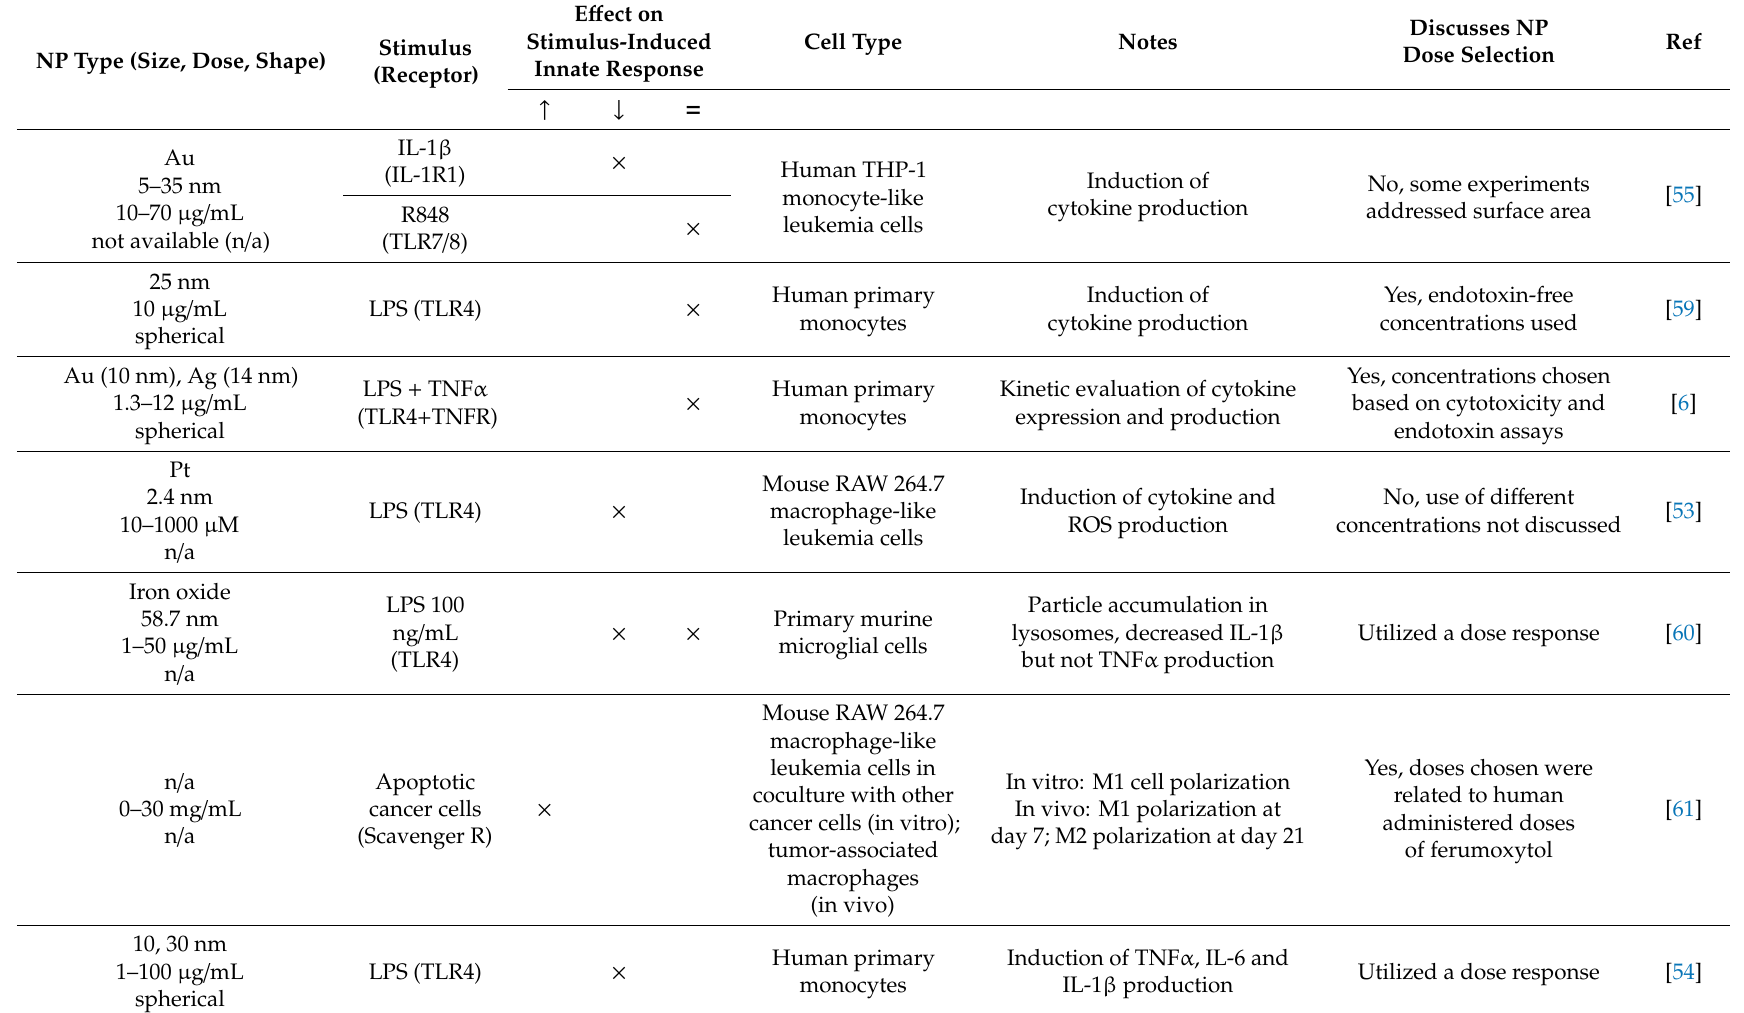
Table 1. Overview on studies investigating the e ff ect of NPs on innate immune cell